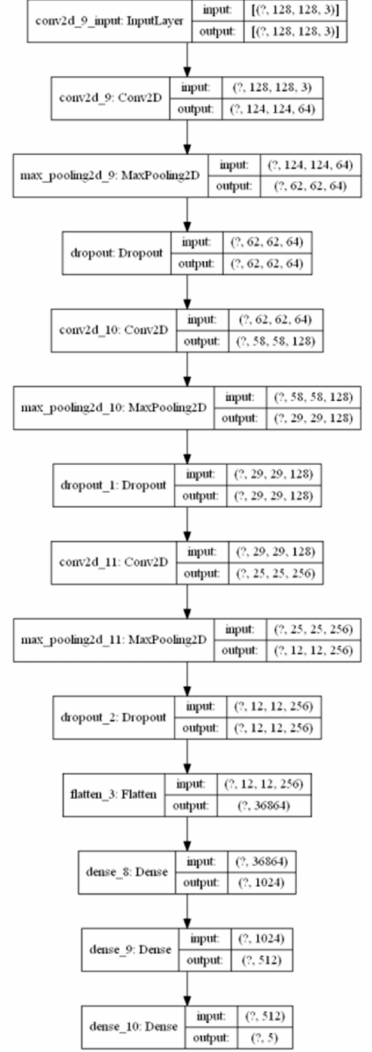
Figure 8. Exemplary parameters of the test convolutional neural network (CNN) architecture applied to PD